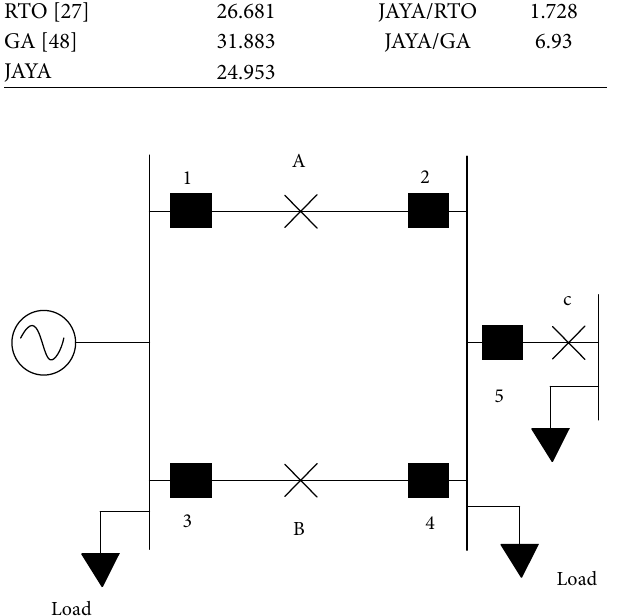
Figure 8: A parallel single end feeder distribution system.